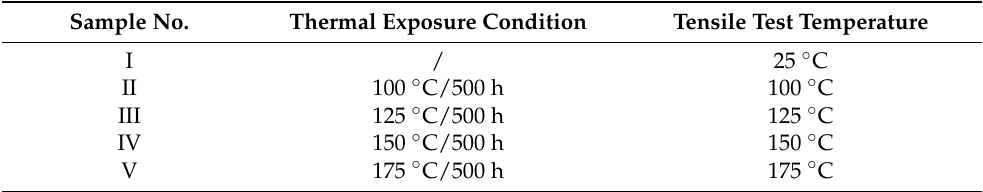
Table 2. The five representative samples of the 7085 Al alloy chosen for the tests. Sample